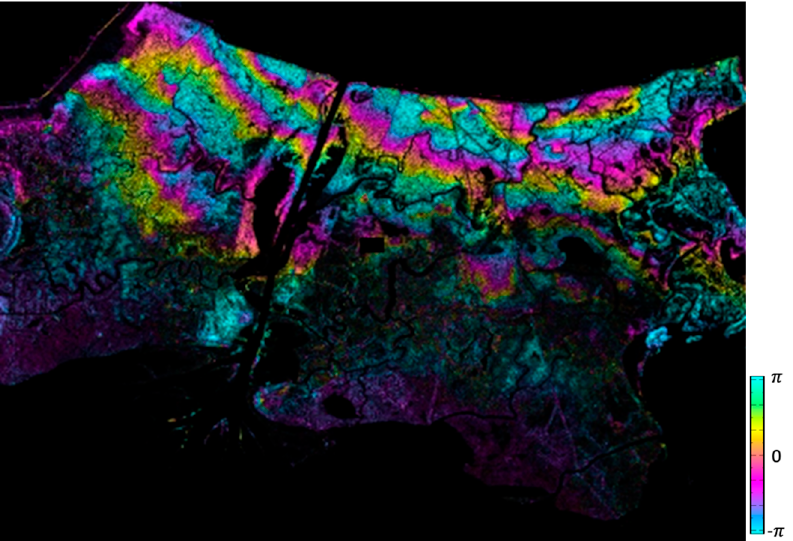
Figure 7. HH-interferogram from InSAR pair of 2008.3.1~2008.4.16. The image brightness stands for the coherence magnitude and the color corresponds to the wrapped InSAR phase between −𝜋 to +𝜋 , which indicates water level change gradients generally run perpendicular to the GIWW.